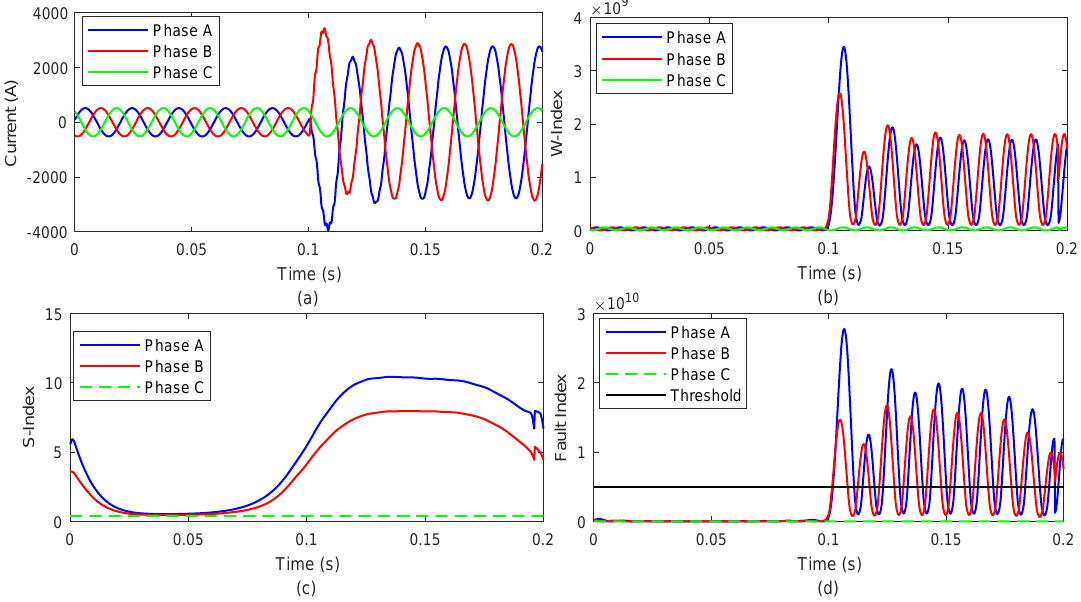
Figure 5. Identification of the fault with an LL-G nature: ( a ) signals of the current ( b ) W-index ( c ) S-index, and ( d )